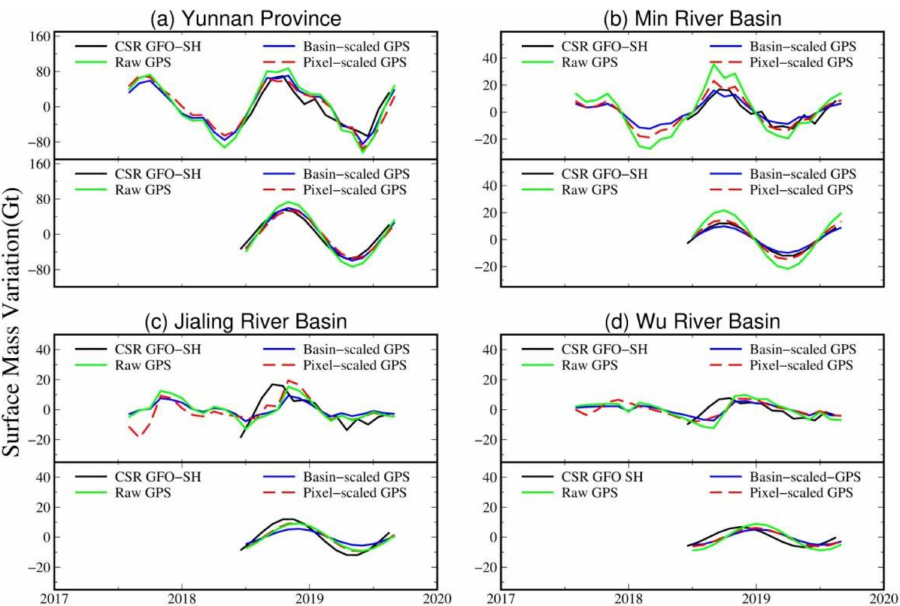
Figure 9. Top of each panel: The raw surface mass change time series (Raw GPS), basin-scaled (basin-scaled GPS), and pixel-scaled (pixel-scaled GPS) time series inverted by GPS vertical displacements from June 2017 to August 2019, and the surface mass change time series modeled by CSR RL06 GFO SH solutions (CSR GFO-SH) from June 2018 to August 2019 for the ( a ) Yunnan Province (YNP), ( b ) Min River Basin (MRB), ( c ) Jialing River Basin (JLRB), and ( d ) Wu River Basin (WRB), respectively. Bottom of each panel: Annual components of the mass change time series for each region from June 2018 to August 2019. Table 3. Statistics of annual amplitudes and phases for the four regions (the Yunnan Province (YNP), Min River Basin (MRB), Jialing River Basin (JLRB) and Wu River Basin (WRB)) based on GPS-derived (Raw GPS, basin-scaled GPS, and pixel-scaled GPS) and GFO-observed (CSR GFO-SH) mass change time series from June 2018 to August 2019, and the RMS of mass change time series minus seasonal variations for CSR GFO-SH, Raw GPS, basin-scaled GPS, and pixel-scaled GPS, respectively. Study